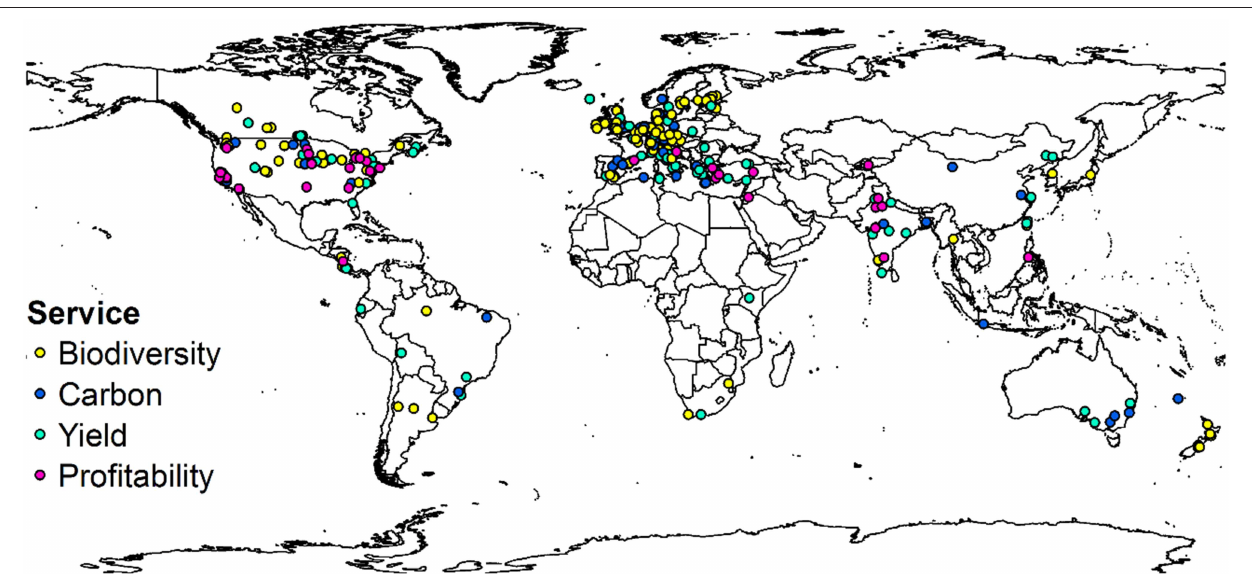
FIGURE 1 | Study locations for seven sustainability metrics: biodiversity (abundance and richness), soil carbon (organic carbon and carbon stock), crop yield, and profitability (benefit/cost ratios and production costs).